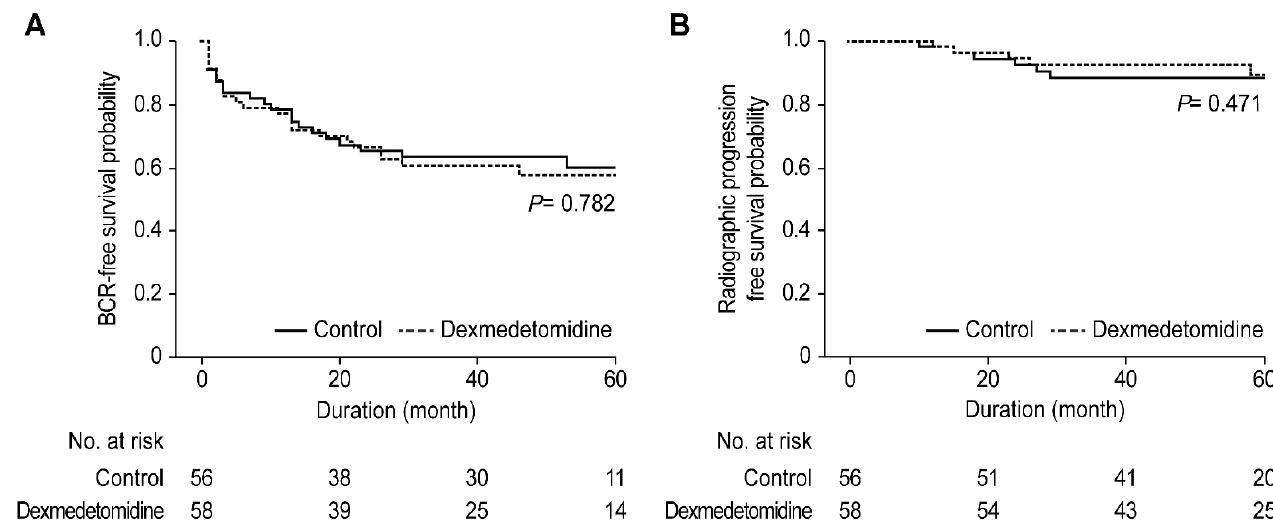
Figure 2. Biochemical recurrence-free survival ( A ) and radiographic progression-free survival ( B ) between the control and dexmedetomidine groups until the 60-month follow-up after robot-assisted laparoscopic radical prostatectomy.